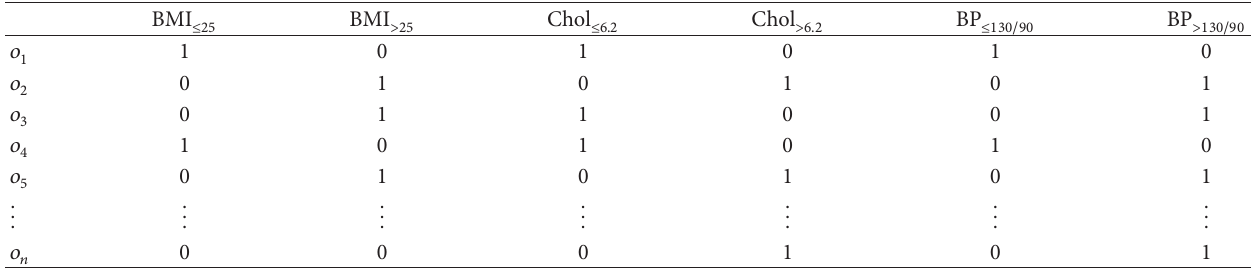
Table 4: Example of GUHA table. BMI ≤25 denotes Body-Mass-Index lower or equal to 25, BMI >25 denotes the same index above 25, Chol ≤6.2 denotes cholesterol lower or equal to 6.2, Chol >6.2 denotes cholesterol higher than 6.2, BP ≤130/90 denotes blood pressure lower or equal to 130/90, and BP >130/90 denotes blood pressure higher than 130/90. Objects 𝑜 𝑖 are particular patients.